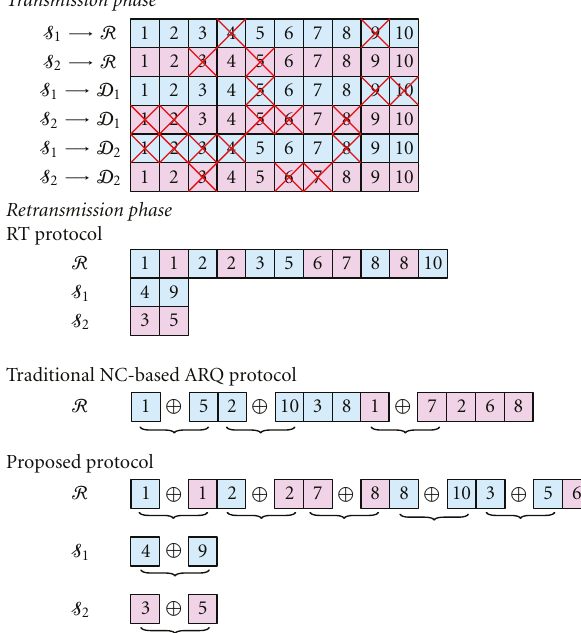
Figure 2: Retransmission with RT, traditional NC-based ARQ, and our proposed